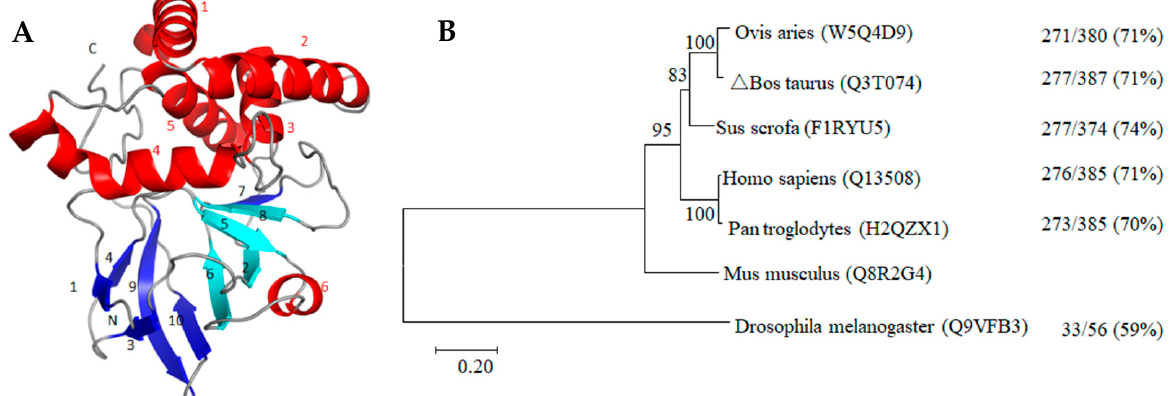
Figure 8. Tertiary structure ( A ) and phylogenetic tree ( B ) of bovine ART3 protein. The spirals, arrows, and loops in ( A ) represent the structures of the α -helices (Red letter number mark), β -strands (Light blue and dark blue letter number mark), and random coils, respectively. The light blue β 2, β 5, β 6, and β 8 indicate the “four-stranded β -core” conserved structure of the ART protein family. ( B ) is the phylogenetic tree constructed using the neighbour-joining method. The uniprot database number of each protein sequence is enclosed in parentheses beside the species name. The branches in the horizontal direction represent the time changes in the evolution of the pedigree. 0.20 refers to the genetic variability of the ART3 protein. The value on the right side of each branch indicates the proportion of the full-length sequence of the same or similar site, whereas that on the right indicates the proportion of the same plus similar sites of the ART3 protein of the species and the mouse to the full-length sequence.